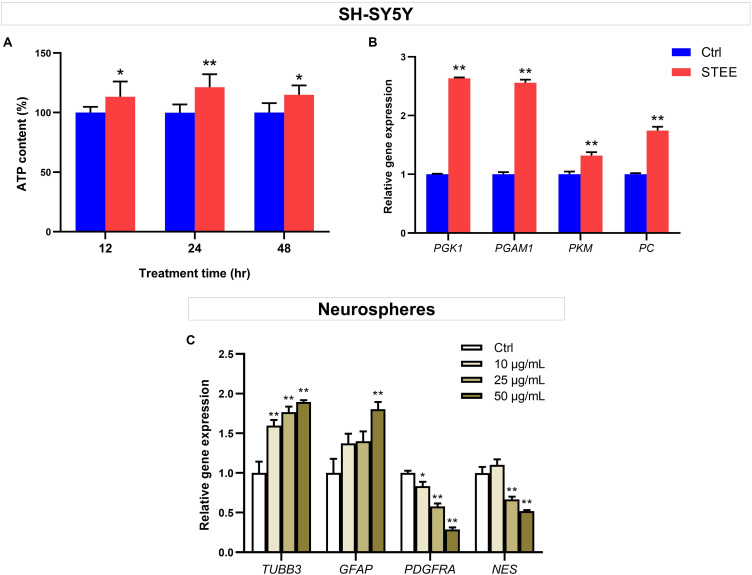
Effect of STEE on neuronal energy metabolism and neurodevelopmental regulation. (A) Intracellular ATP content in SH-SY5Y cells at different time points (12, 24, and 48 h after treatment) were measured as emission intensity. The cells were treated with 50 μg/mL of STEE (or non-treatment). Results are expressed as relative to control percentages and presented as mean ± SD. Comparisons between two groups were performed by Student’s t-test: *p < 0.05 and **p < 0.01. (B) qRT-PCR analyses of PGK1, PGAM1, PKM, and PC transcript levels in STEE (50 μg/mL) treated neuronal cells. Results are shown as relative to control values. Values are expressed as mean ± SEM (triplicates from three independent experiments). Comparisons were performed using Student’s t-test: **p < 0.01. (C) Effects of STEE on the expressions of neurodevelopmental genes in neurospheres. TUBB3 (neuronal marker), GFAP (astrocytic marker), PDGFRA (oligodendrocytic marker), and NES (stem cell marker) transcript levels were determined with qRT-PCR. Results are expressed as relative to control values. Values are presented as mean ± SEM (triplicates from three independent experiments). Comparisons were performed using one-way ANOVA followed by Dunnett’s post hoc test: *p < 0.05 and **p < 0.01.